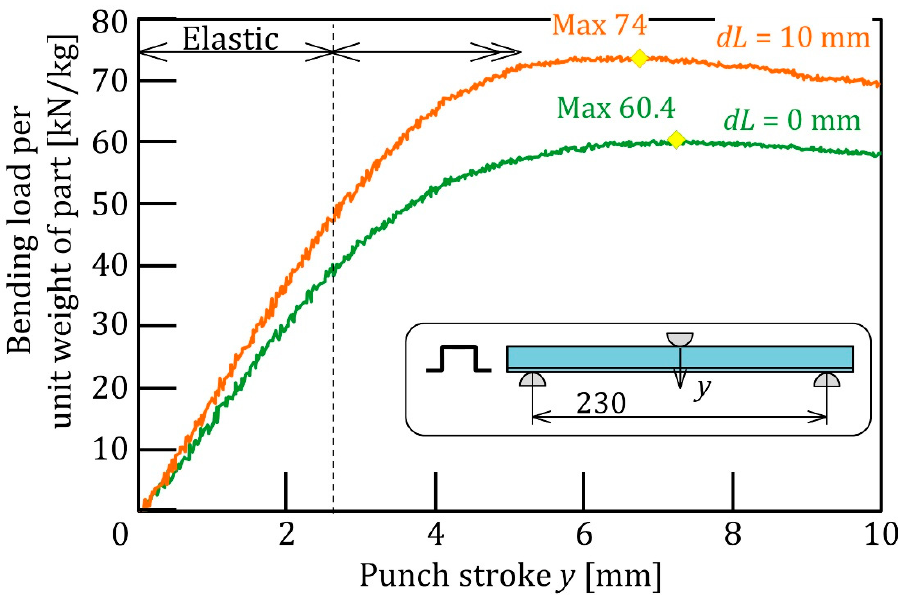
Figure 17. Bending load–punch stroke curve in three-point bending of hot-hat bent parts using planar compression with and without partial cooling.